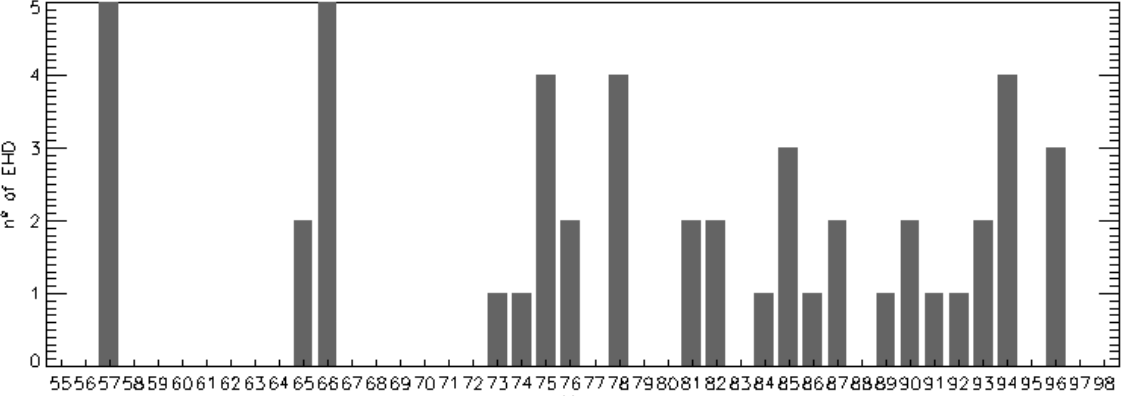
Fig. 5. Annual frequency for EHD occurring under southern flux conditions.